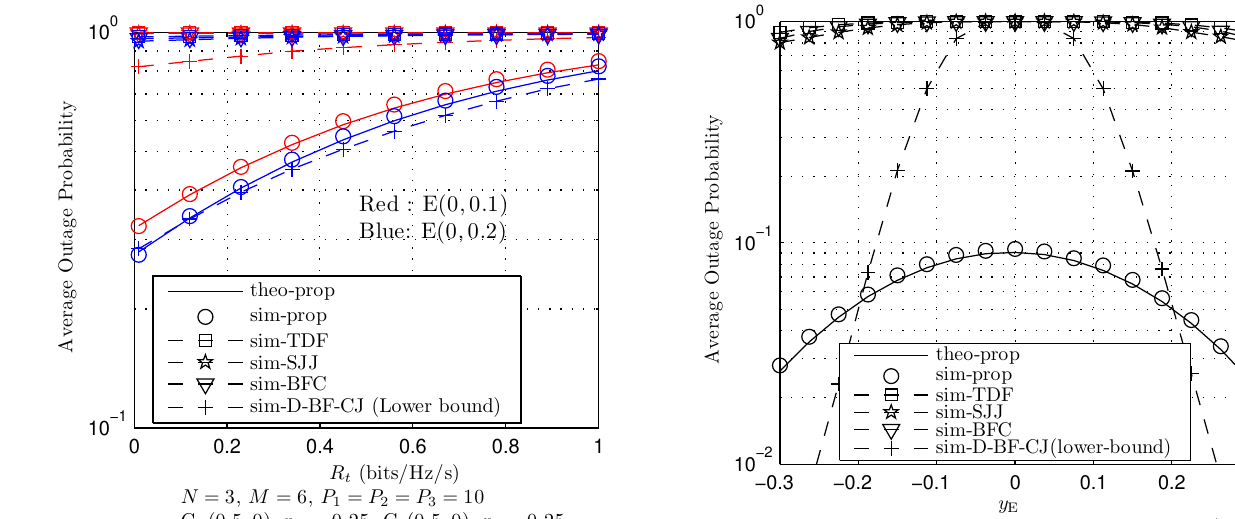
Figure 6. Outage performance in relation to the changes in the possition of the eavesdropper. M = 6 , N = 10